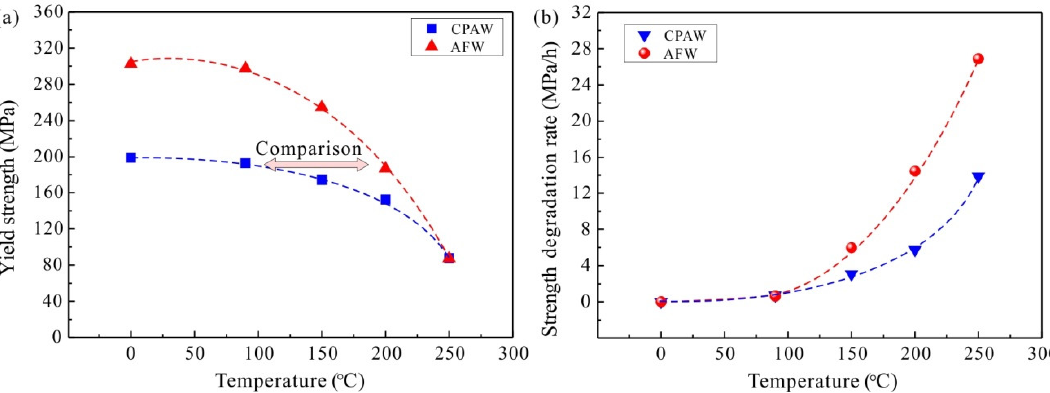
Figure 1. The yield strength-temperature relation ( a ) and the strength degradation rate-temperature relation ( b ) of the annealed commercially pure Al wires (CPAWs) and the annealed Al-Fe wires